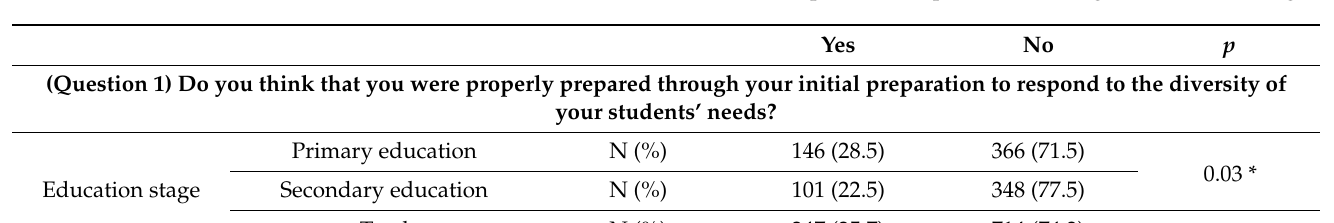
Table 2. Distribution of the three dichotomous questions responses according to educational stage.